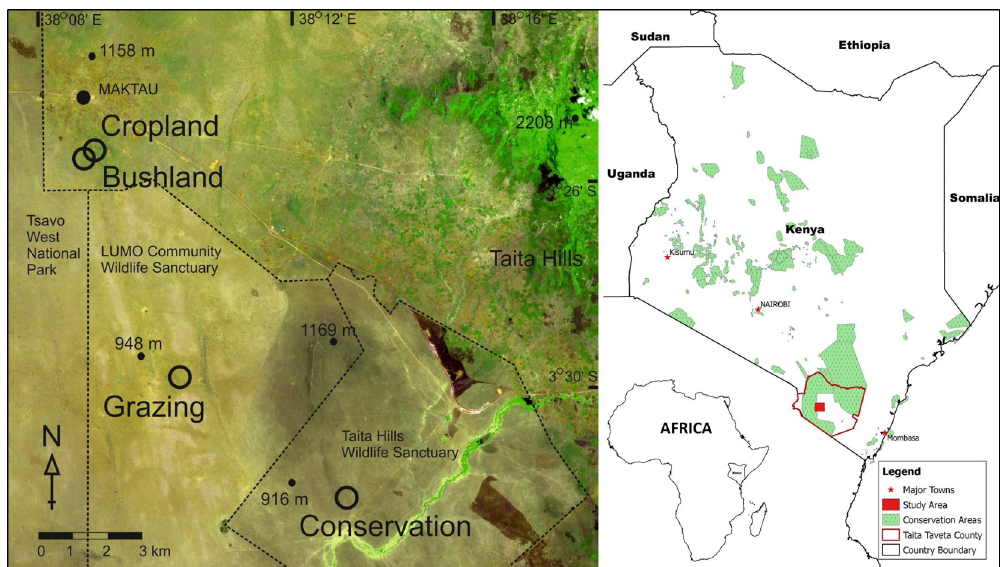
Figure 1. Location of the study sites showing the cropland, bushland, grazing land, and conservation land sites in the savanna area in the lowlands of Taita–Taveta County in southern Kenya. The image showing the sites is from Sentinel-2A acquired from the Sentinels Scientific Data Hub (ESA, 2015). The Kenyan and African boundaries are from ©World Resources Institute (retrieved from https://www.wri.org/ resources/data-sets/kenya-gis-data, last access:14 February